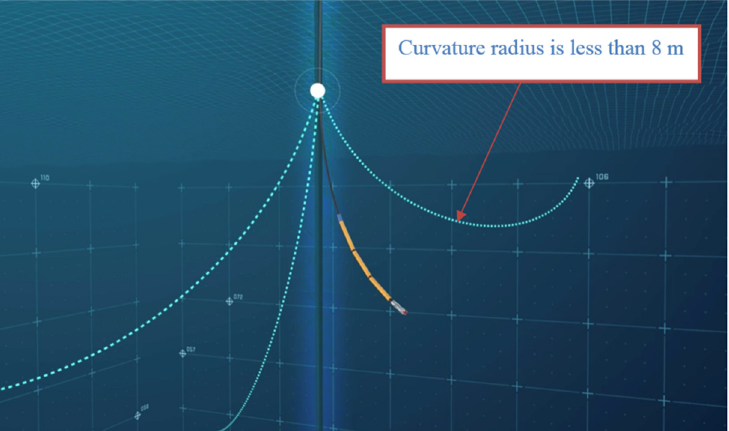
Figure 1. Network of branched channels of drilled using TS Perfobore.